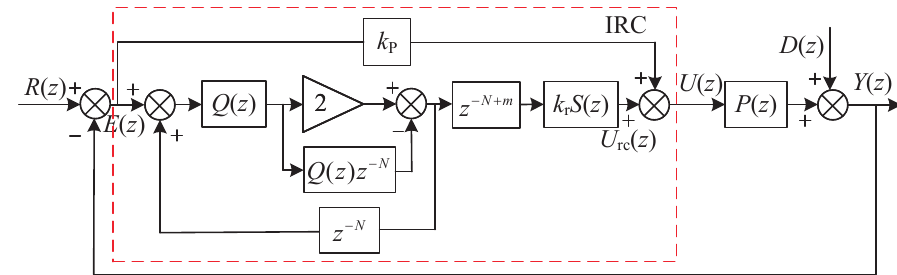
Figure 7. Block diagram of the proposed IRC system.